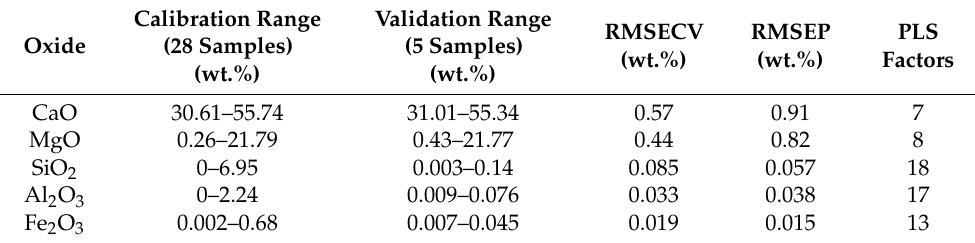
Table 2. PLS model summary.